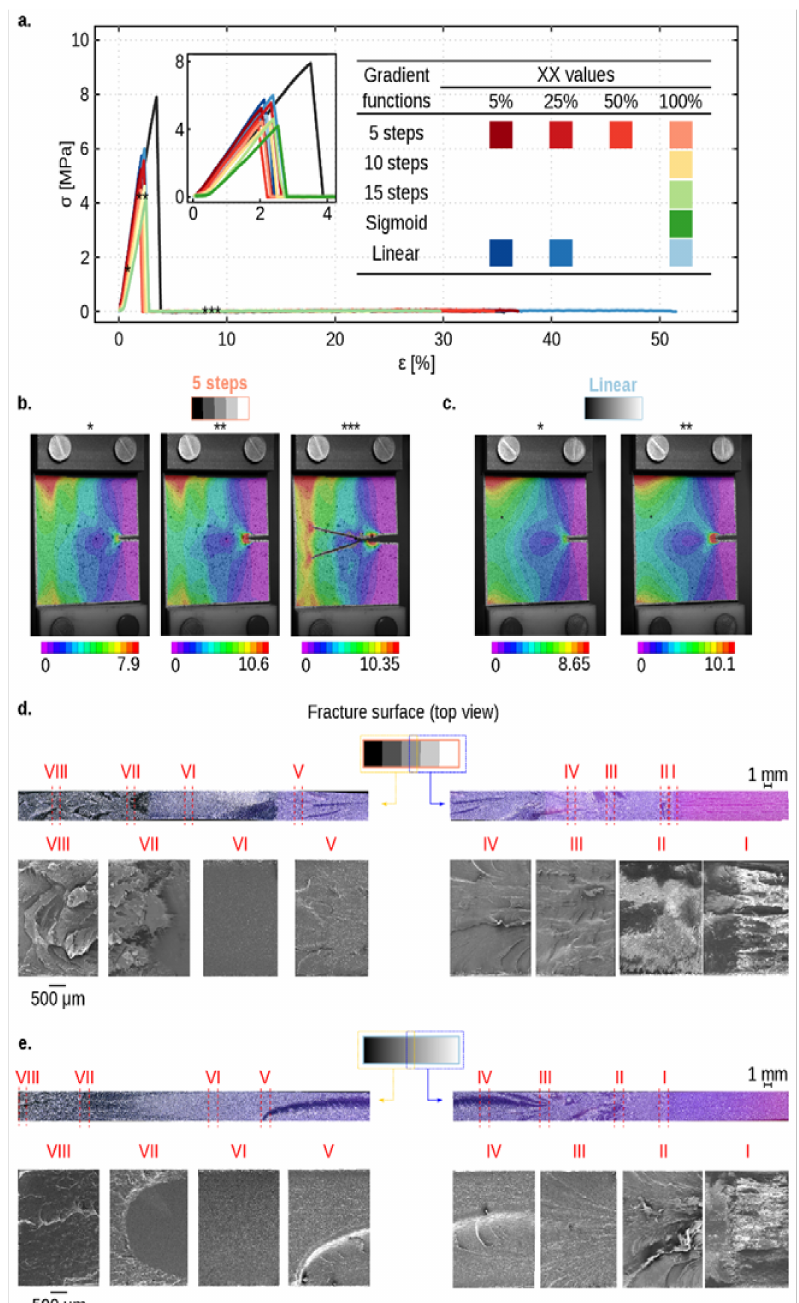
Figure 2. ( a ) Typical stress–strain curves of specimens with graded or non-graded interfaces. The inset shows a magnified view of the stress–strain curves until 4% strain. Full-field strain measurement using digital image correlation (DIC) of specimens with five steps ( b ) and linear ( c ) transition functions. DIC images show von Mises strain before maximum load (*), at the maximum load (**), and after maximum load (***). Digital microscopy images (200 × magnifications) and the corresponding scanning electron microscopy (SEM) (35,000 × magnifications) analyses of the fracture surface of the specimens with five steps and linear transition function are presented in sub-figures ( d ) and ( e ), respectively. The SEM images show the zoomed-in images of eight regions of structures. The scale bars for the digital microscopy images are on top of the corresponding images and underneath the SEM images. The hard phase is in white pixels, while the soft phase is in black. The size of the transition length was 100% W for the specimens in subfigures ( b – e